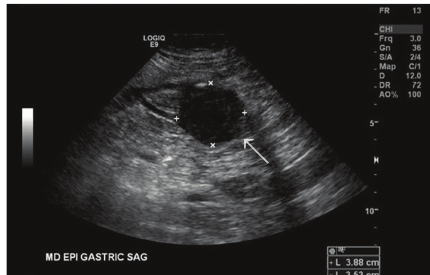
Figure 1: Transabdominal sonogram reveals a round and well-defined mass in the stomach.